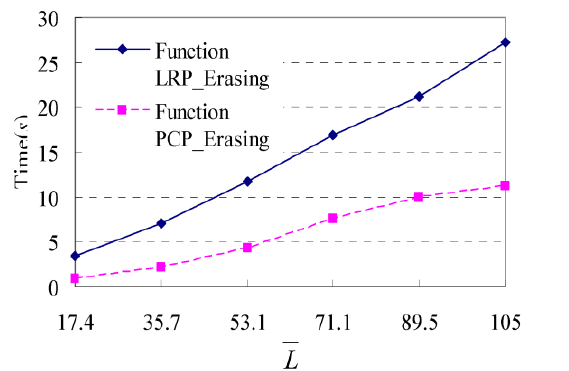
Figure 12. Execution time in response to changes in different L